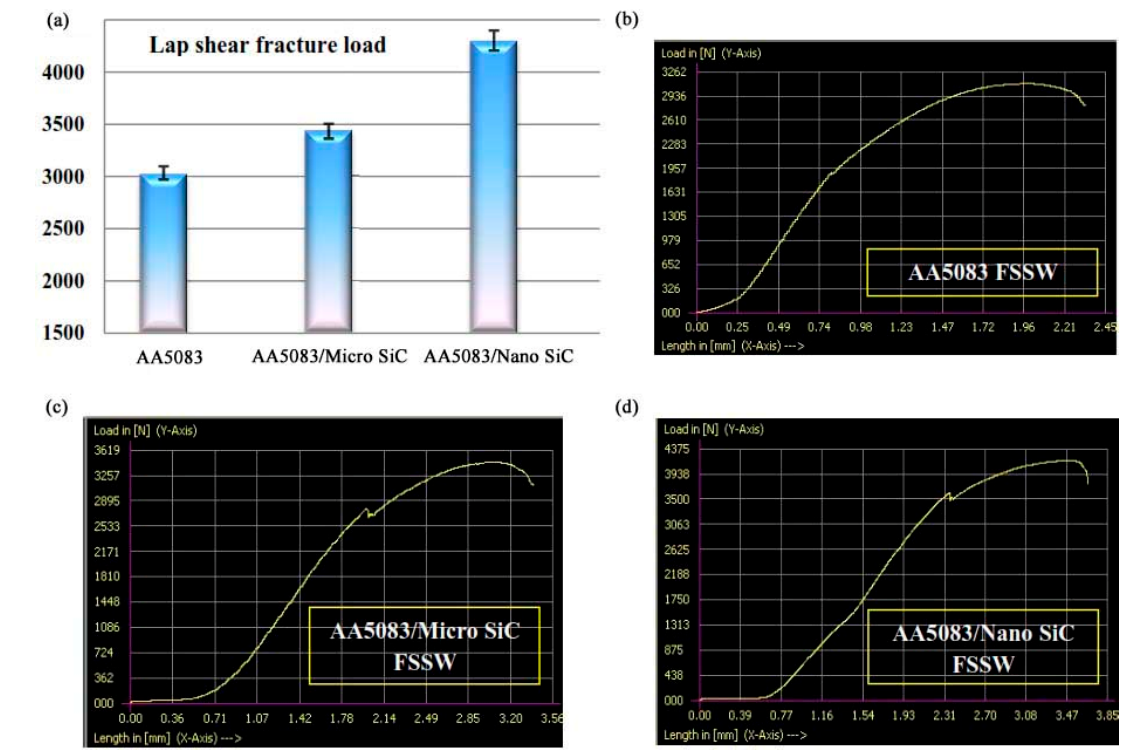
Figure 9. ( a ) Lap shear fracture load. ( b – d ) Load–displacement curves.